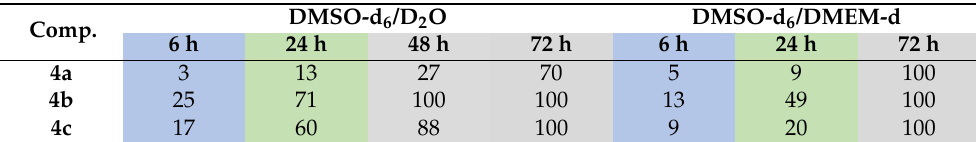
Table 2. Fraction (%) of diiron complex (measured as released cyclopentadiene, two CpH units being released per molecule [19]) degraded in aqueous solutions stored at 37 ◦ C after variable times (hours).